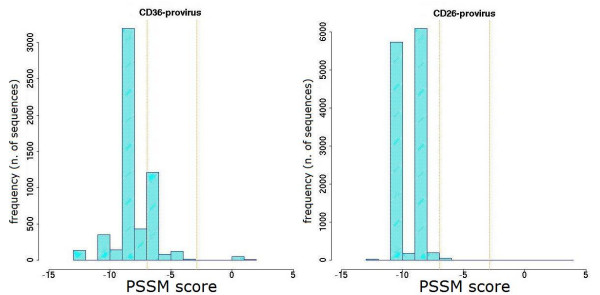
PSSM score distribution of V3 amino acid sequences from Pt.1. The PSSM score distribution of all the detected variants from CD36- and CD26-provirus present in Pt.1 at the moment of therapy interruption are shown. Vertical orange lines indicate 95th and 5th percentiles for CXCR4 and CCR5 predicted co-receptor usage (> -2.88 and < -6.96 respectively).